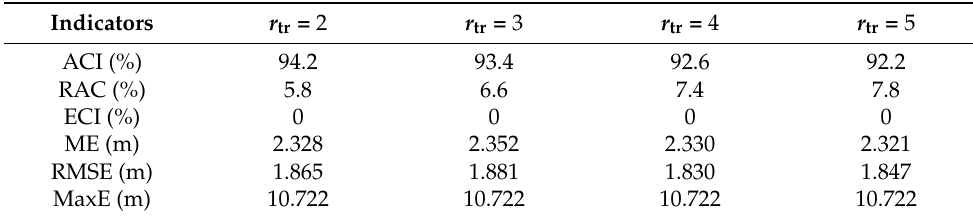
Table 5. Statistics of cluster identification and localization with different